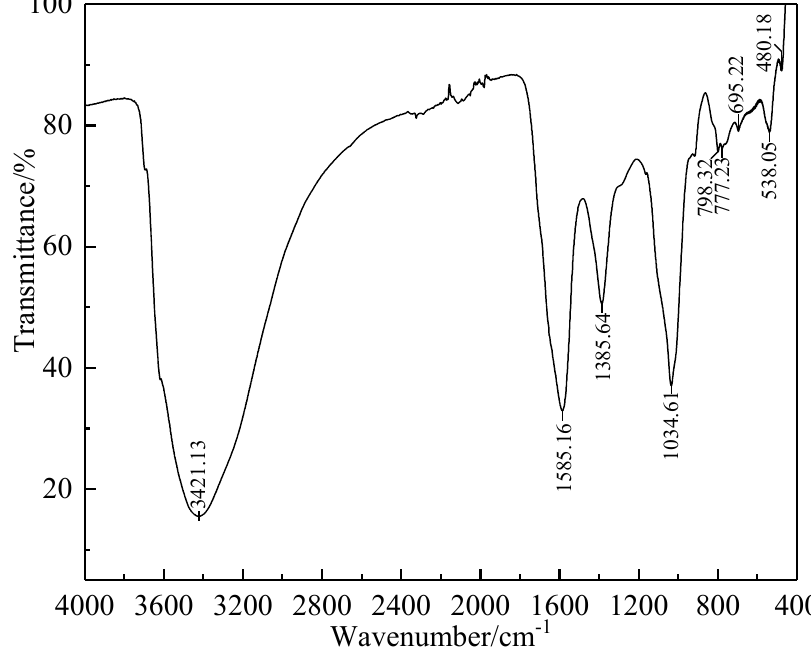
Figure 4. FTIR curves of humic substance-based binder.